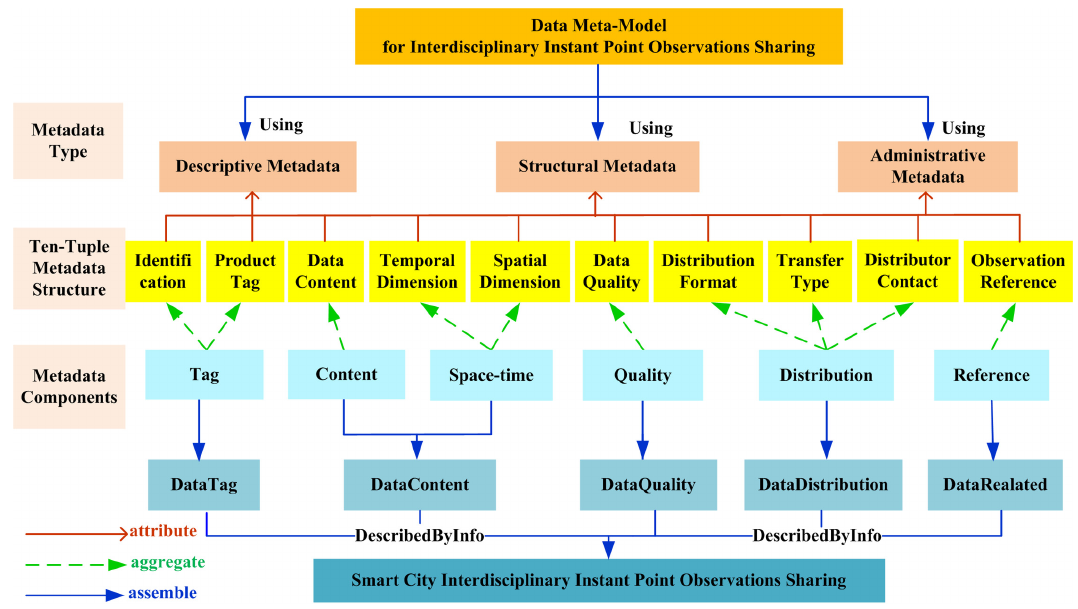
Figure 3. Organization of spatio-temporal enhanced metadata for interdisciplinary instant point observations sharing.